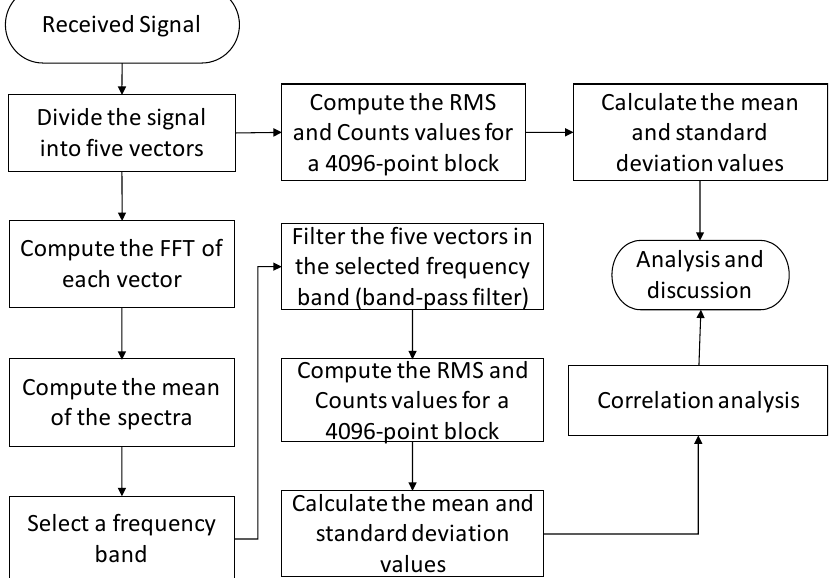
Figure 4. Flowchart of the digital signal processing scheme.